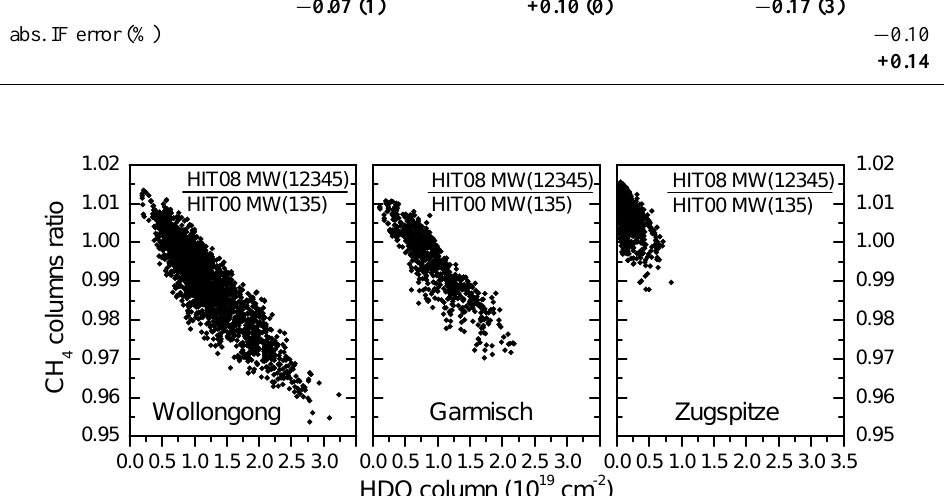
Fig. 7. Investigation of the seasonal artifact shown in Fig. 6: ratio of about one year of methane retrievals with two differing retrieval strategies as in Fig. 6, now plotted as a function of HDO column level for the 3 test sites (HDO columns are from the joint HDO retrieval of the HIT00 MW (135)